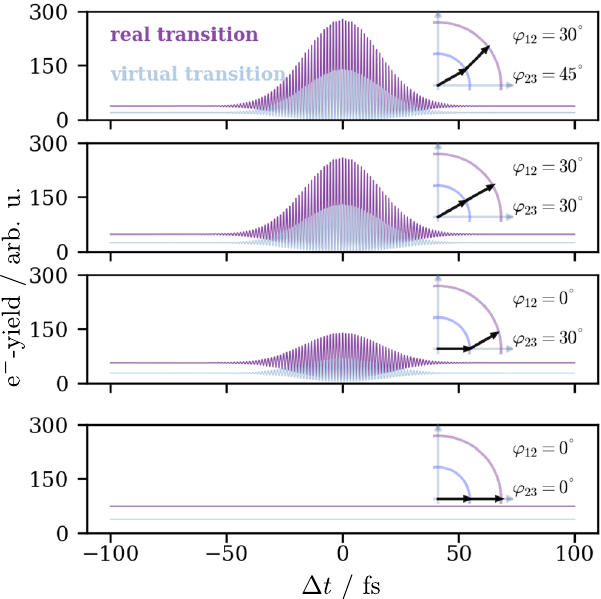
Fig. 3 OTD-orientation dependent cross-polarized correlation traces. Simulated cross-correlation traces for different angles between the electric fi eld and the optical transition dipoles for real (purple) and virtual (light blue) transitions. The different orientations alter the overall correlation signal strength. Supplementary Figure 4 contains simulations for additional angle